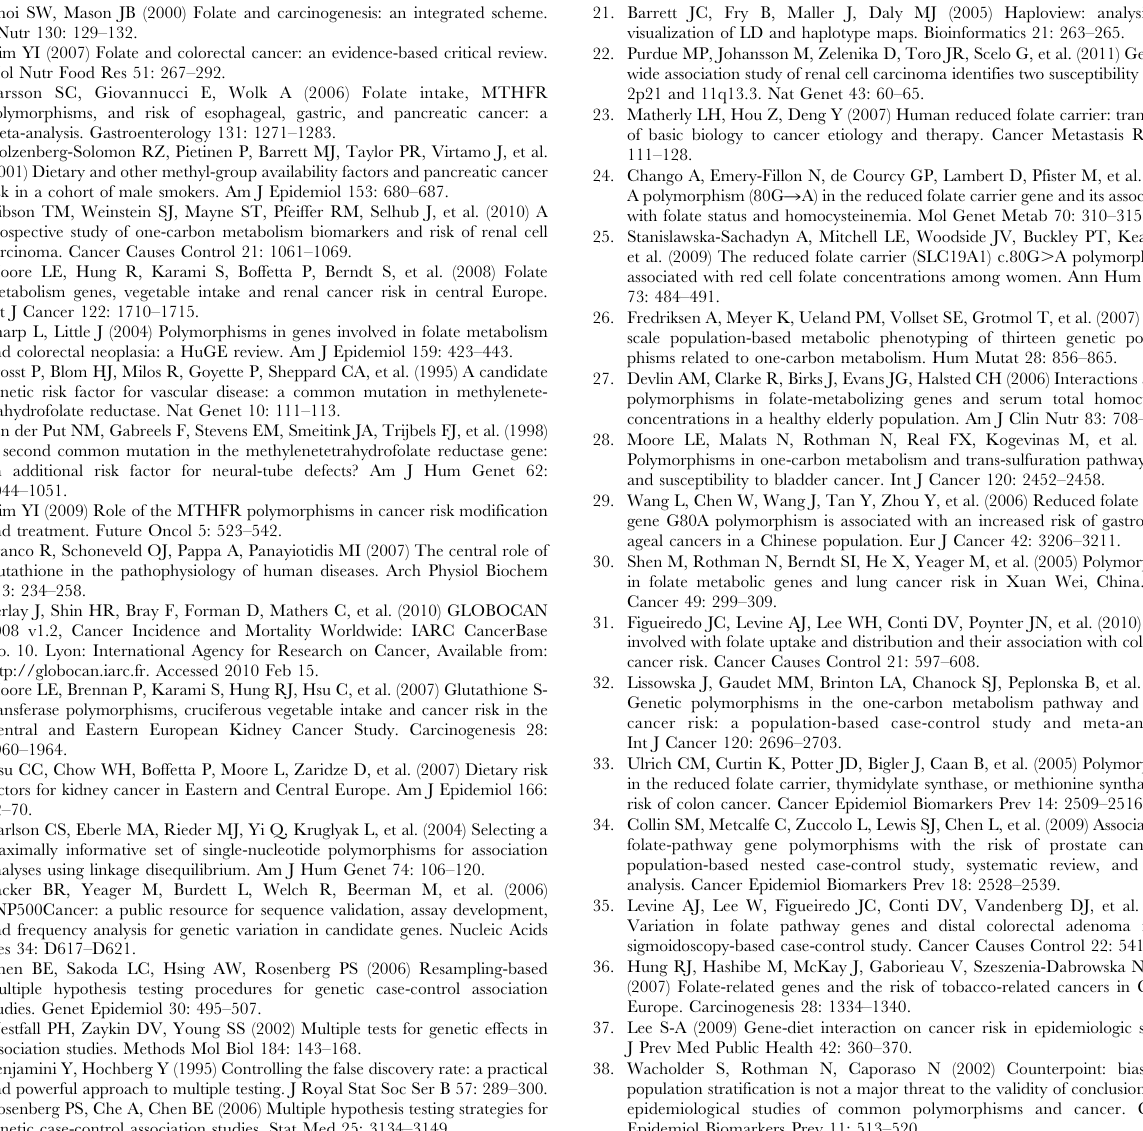
Table S1 Main effects SNP-based analyses for genes in the one-carbon metabolism pathway and RCC